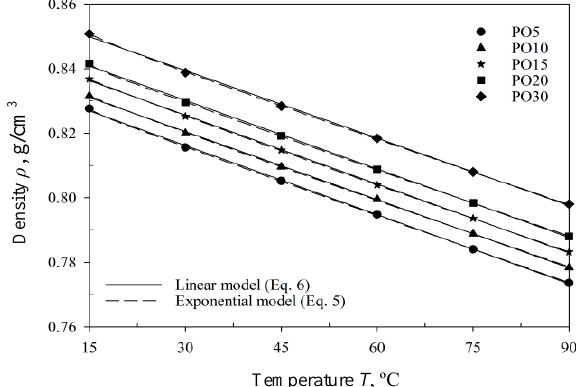
Fig. 4. Changes of densities of PO5–PO30 with respect to